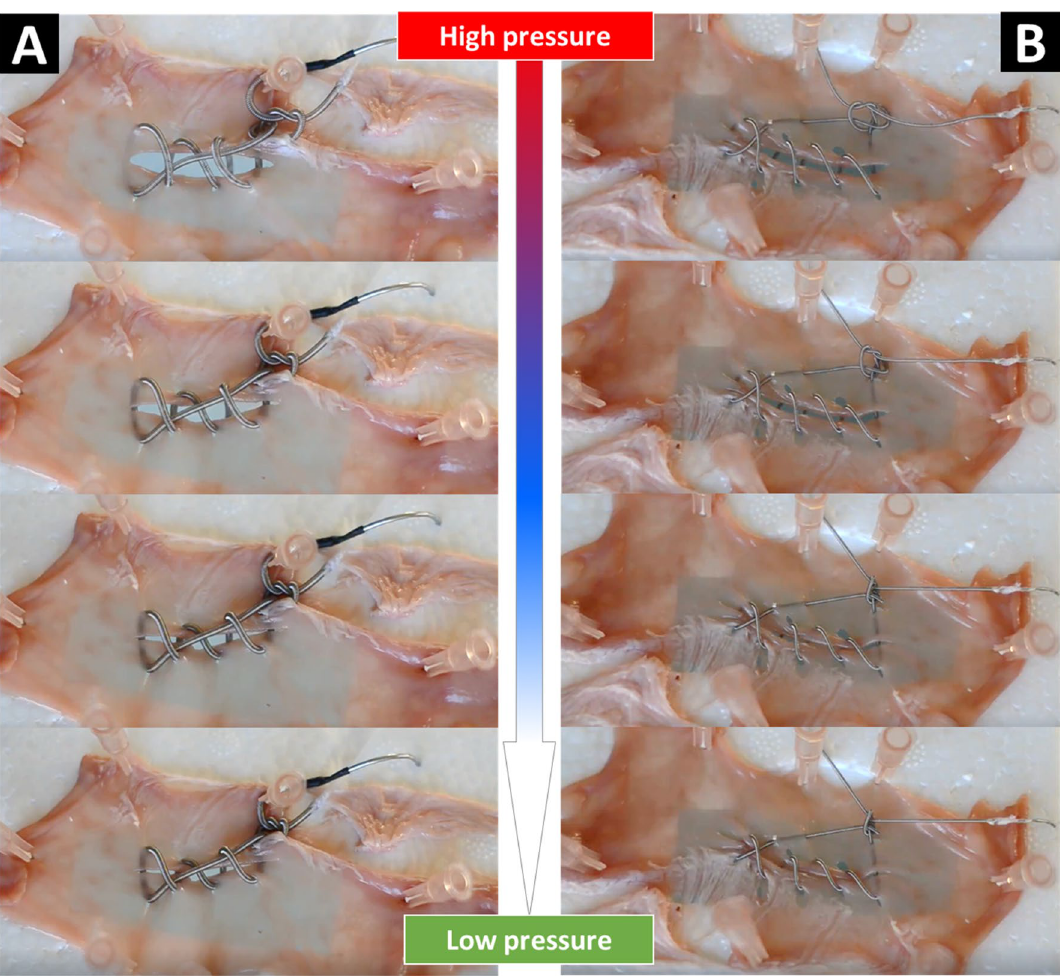
Figure 8. Perforation closure with the S 2 suture-knots on a fresh porcine colon. ( A ) Results for the S 2 suture- knot OD1.49 × L70 mm. ( B ) results for the S 2 suture-knot OD0.8 × L100 mm. These demonstrations are available in the Supporting